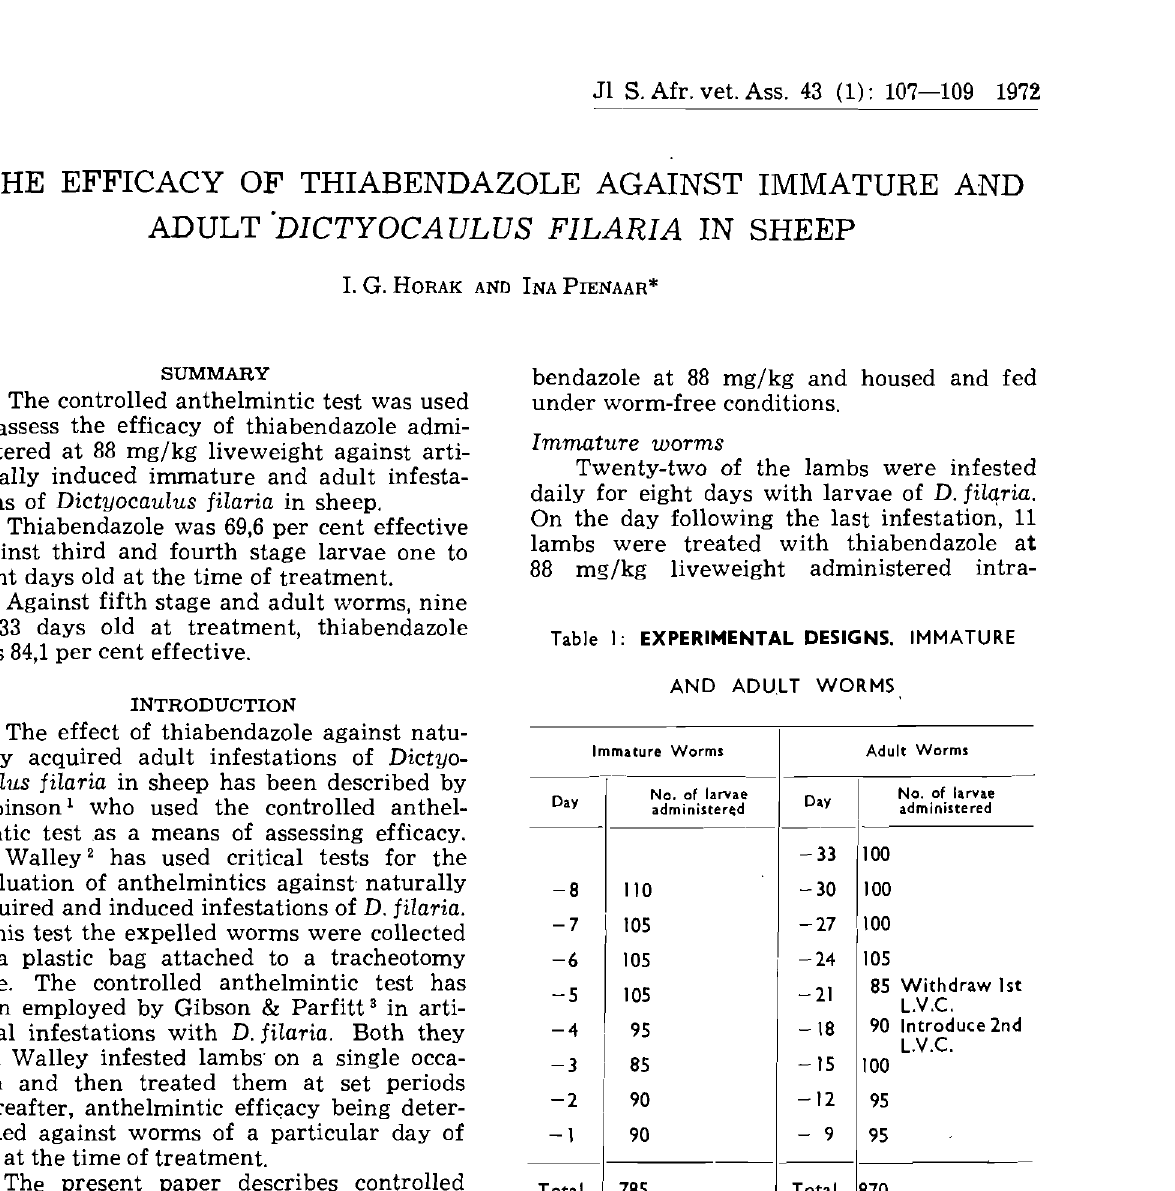
Table I: EXPERIMENTAL DESIGNS. IMMATURE AND ADU.L T